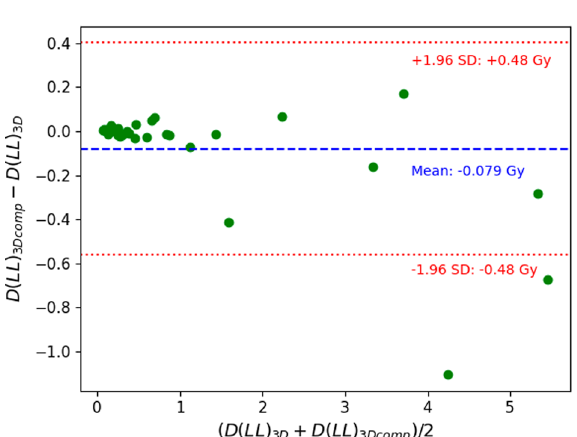
Fig. 8 Bland–Altman plot of the left lung dose (Gy) between 3D and 3Dcomp reconstructions for each patient. D(LL) 3D and D(LL) 3Dcomp correspond to the left lung dose estimated from the 3D and 3Dcomp reconstructions,